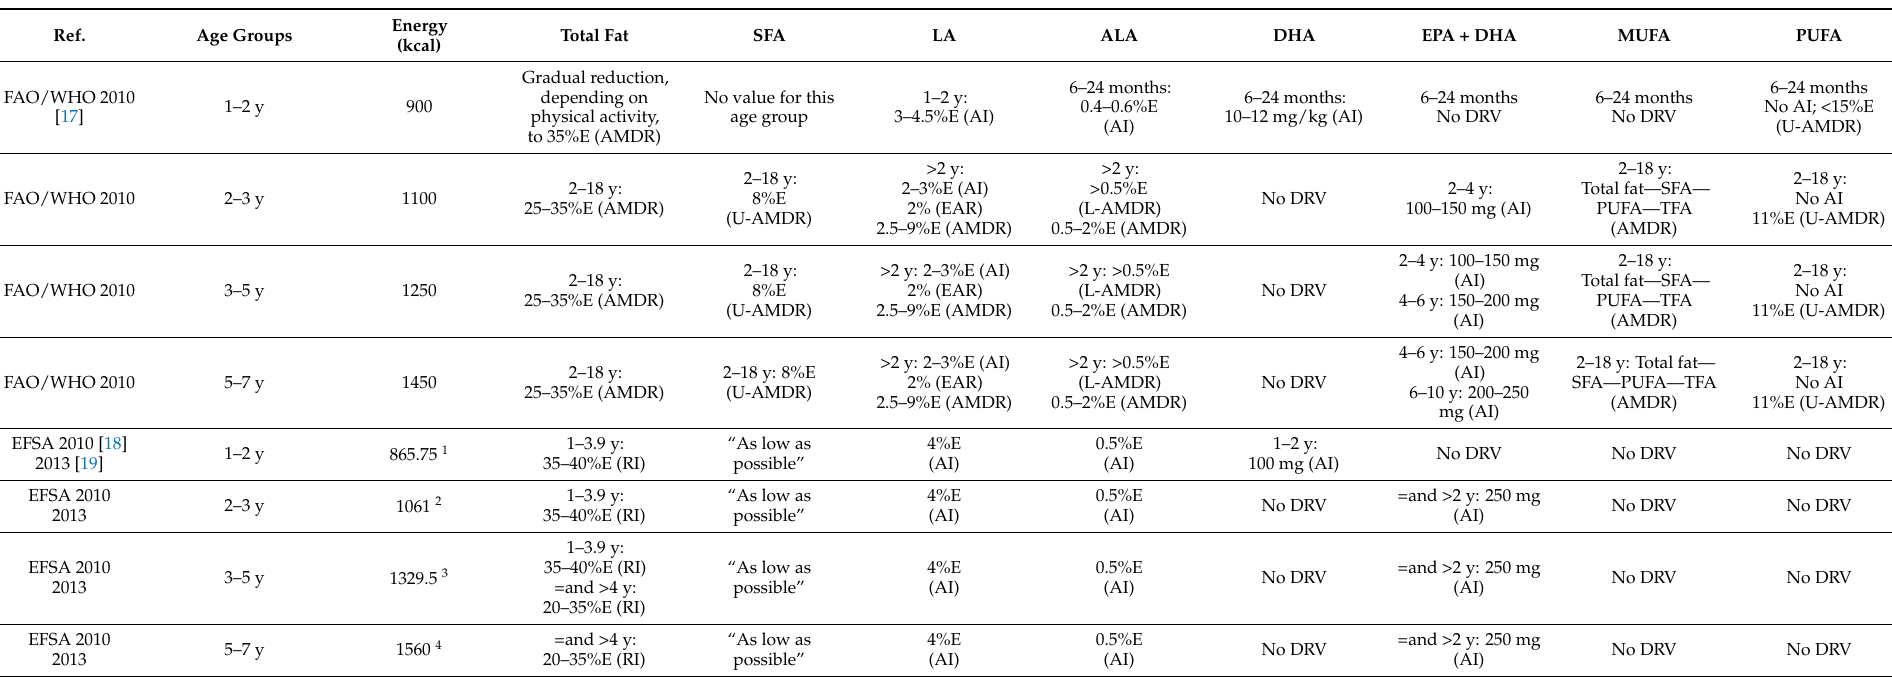
Table 1. FAO/WHO dietary recommended intakes and EFSA dietary reference values for energy, total fat, SFA, LA, ALA, DHA, sum of EPA+DHA, total MUFA and total PUFA for children aged 1–2 years, 2–3 years, 3–5 years and 5–7 years.